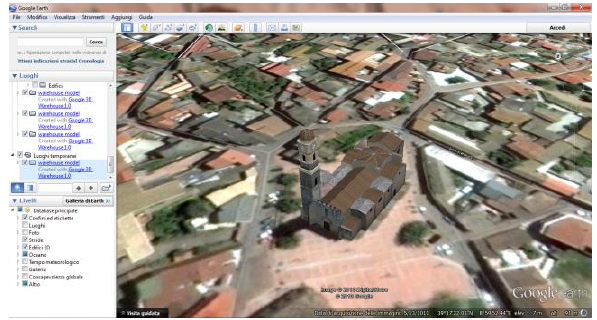
Figure 8. The church of San Pietro in Assemini, in the 3D layer of Google